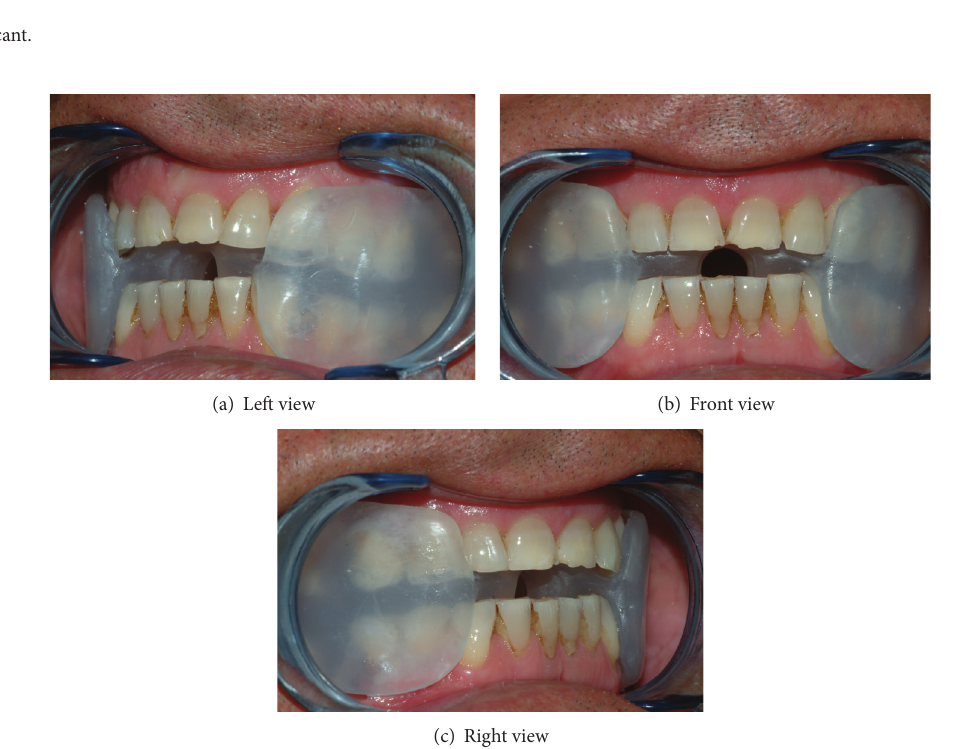
Figure 1: Soft monobloc mandibular advancement device